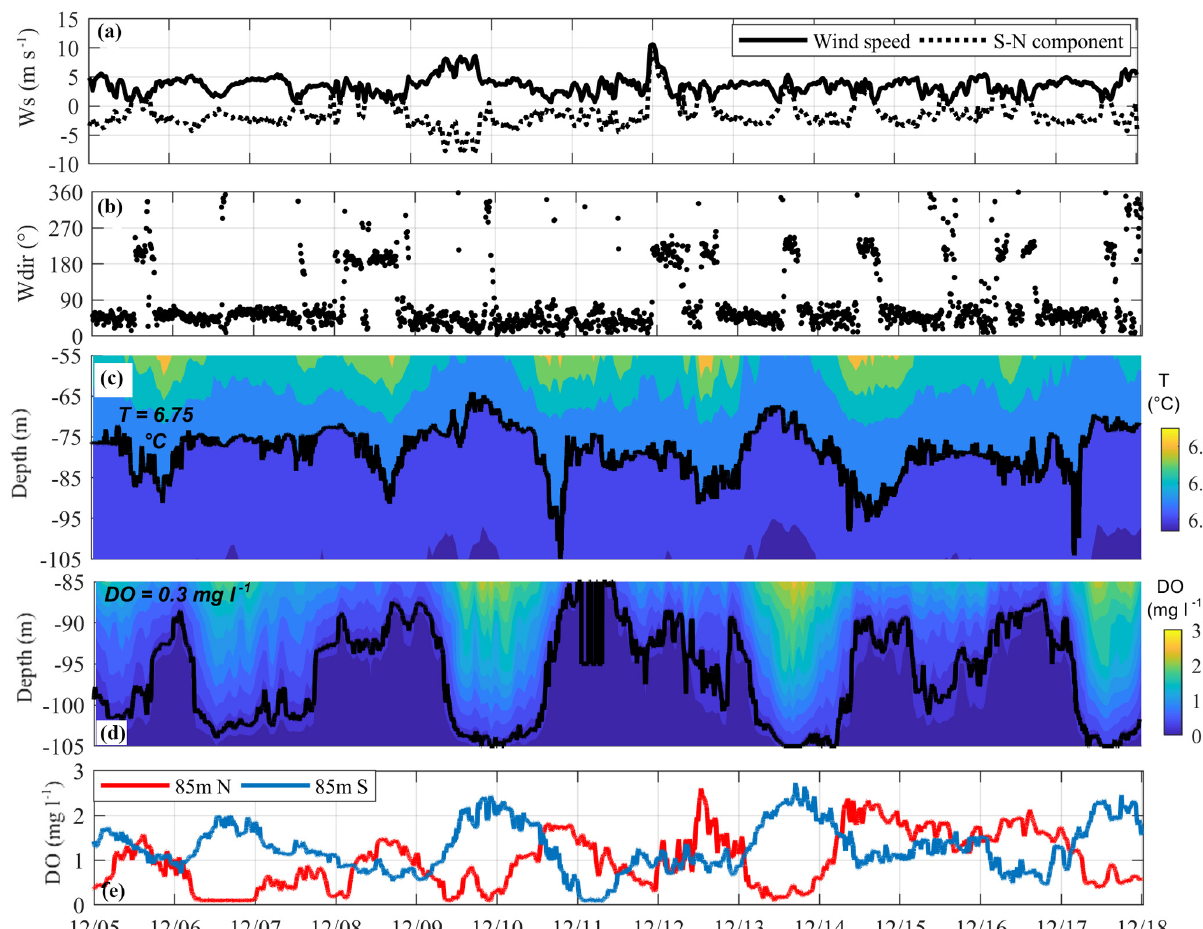
Figure 6. Same as Fig. 4 but referring to the period 5–18 December